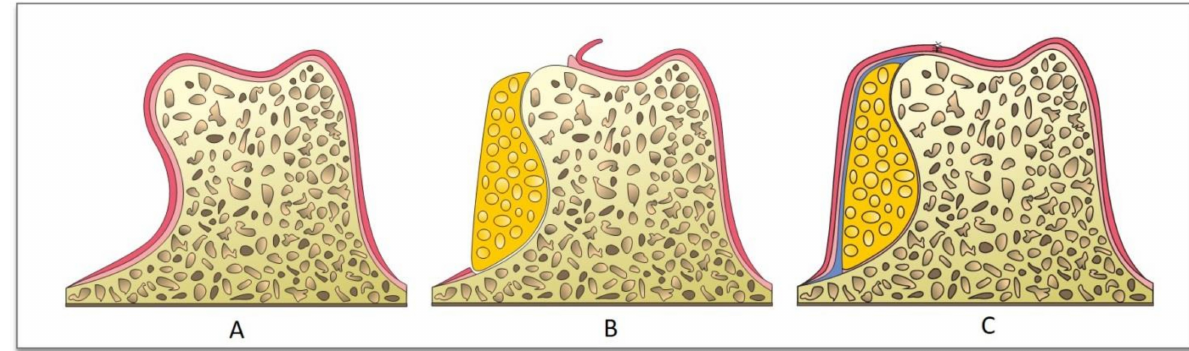
Figure 5. Diagram showing a regenerative technique in an area with the bone defect. ( A ) Alveolar ridge with a bone defect in thickness. ( B ) Bone graft adapted to the area of the defect and membrane positioned. ( C ) Suturing the grafted area.